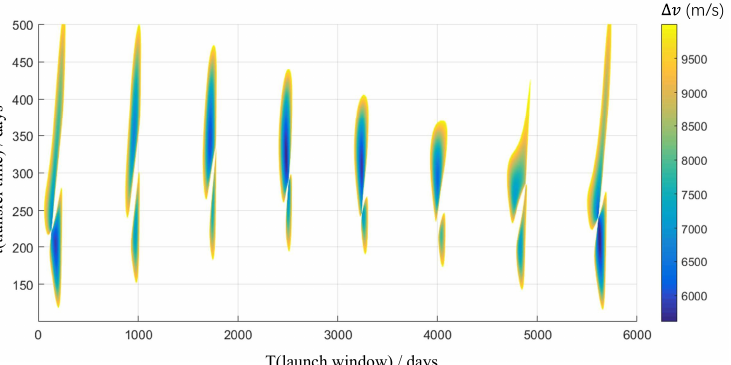
Figure 5. Total ∆ v for Earth-to-Mars Lambert transfer from 2035 to 2050. The horizontal axis is launch windows (in days after 1 January 2035), and the vertical axis is transfer time (in days).